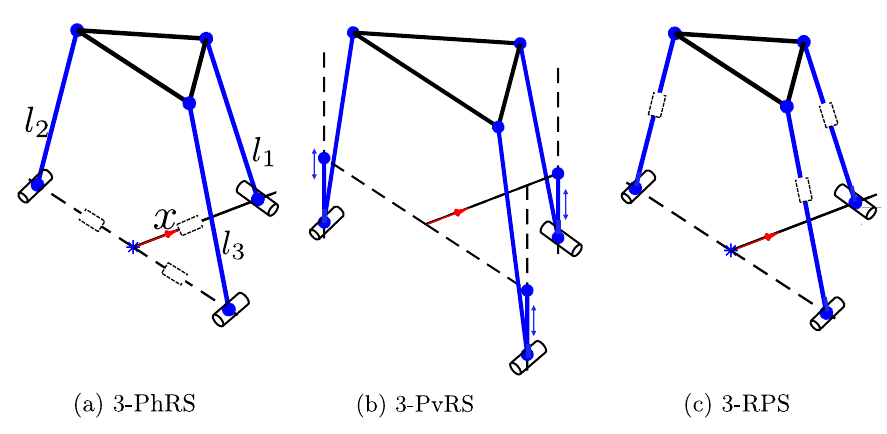
Figure 5. Optimal configuration for v x =